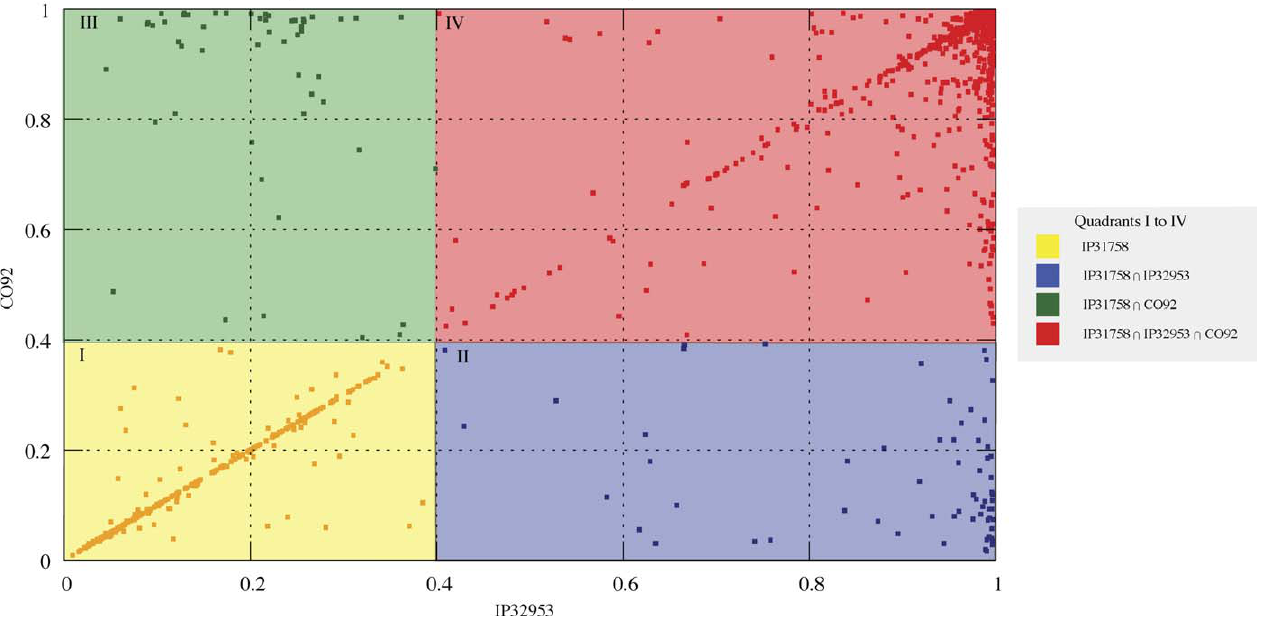
Figure 3. BLAST Score Ratio Analysis of Y. pseudotuberculosis Strains IP31758 and IP32953 and Y. pestis CO92 BLAST score ratios were plotted as x , y coordinates. Each protein in the reference genome ( Y. pseudotuberculosis IP31758) was grouped into four quadrants according to its scores in each of Y. pseudotuberculosis IP32953 and Y. pestis CO92 genomes and colored as follows: yellow (I), unique to IP31758; red (IV), common to all three; blue (II), common between IP31758 and IP32953 but absent in CO92; green (III), common between IP31758 and CO92 but absent in IP32953.